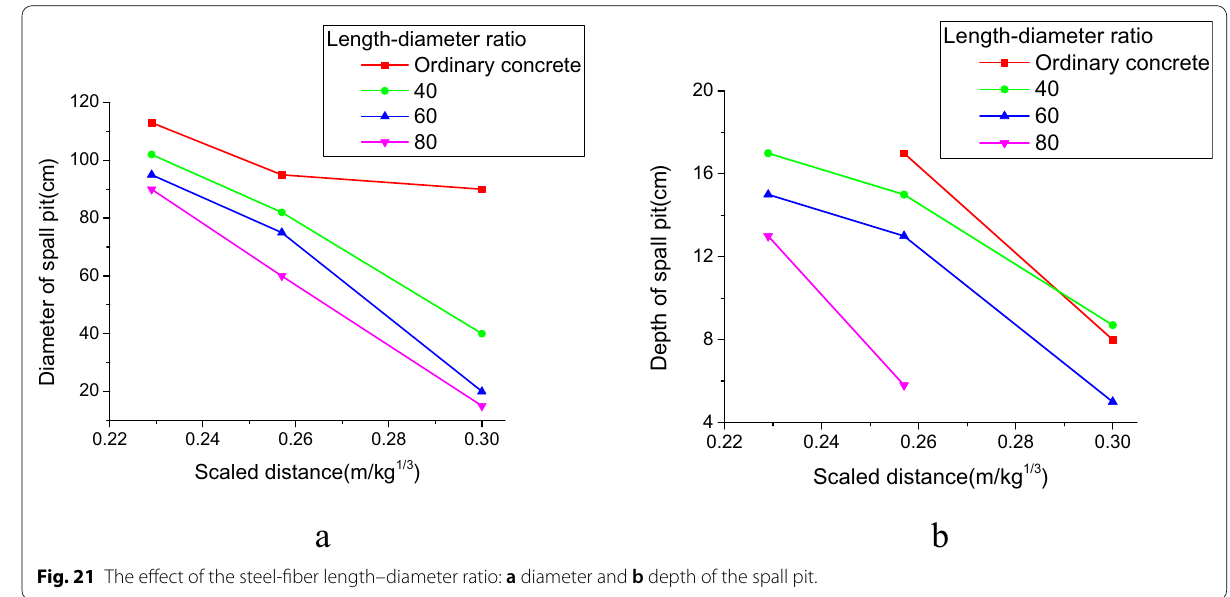
Fig. 21 The effect of the steel-fiber length–diameter ratio: a diameter and b depth of the spall pit.